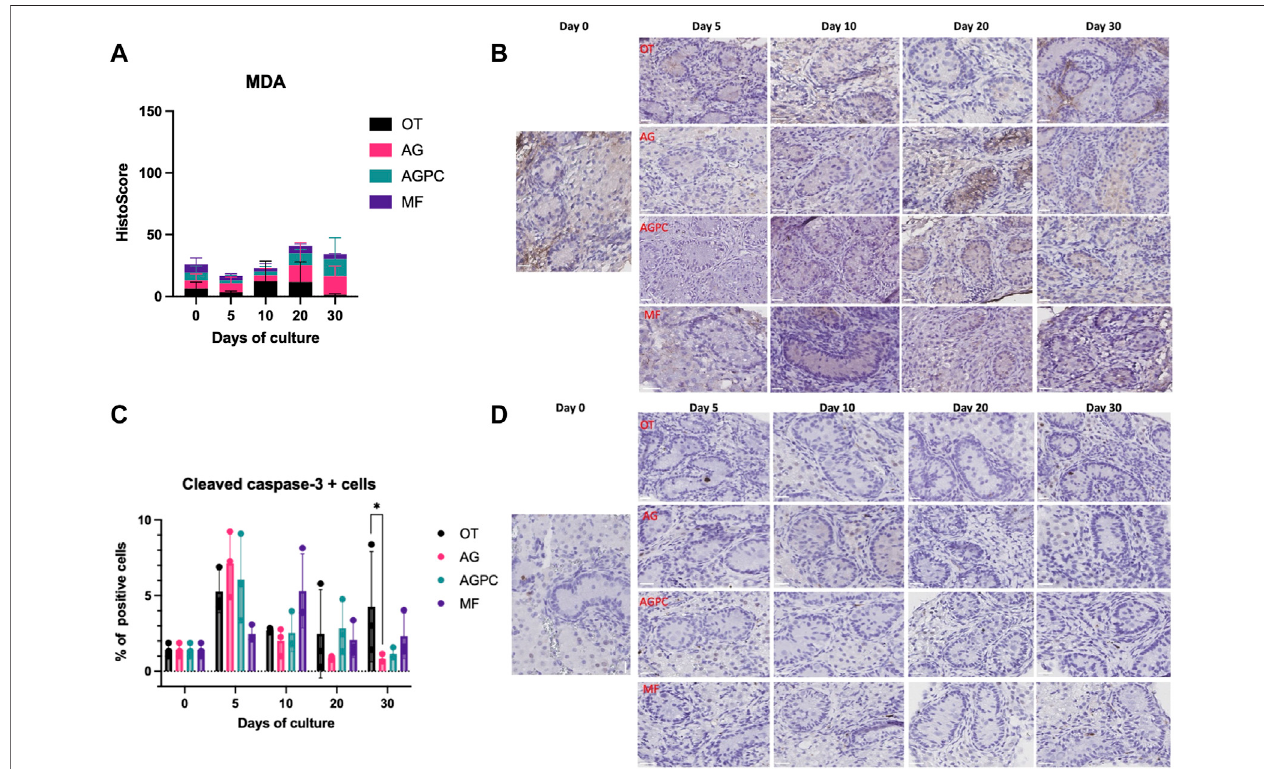
FIGURE5| Evolutionofapoptosisandoxidativestressmarkersoverthecultureperiod. (A) EvolutionoftheMDAstaining(HistoScore)levelsoverthecultureperiod. (B) MDA staining on immunohistochemistry. (C) Evolution of the percentage of cleaved caspase-3 positive cells over the culture period. (D) Cleaved caspase-3 immunohistochemistry. OT, culture insert PTFE; AG, Agarose; AGPC, Agarose + PDMS cover; MF, Micro fl uidic. Images shown at ×400 magni fi cation, Scale bars = 20 μ